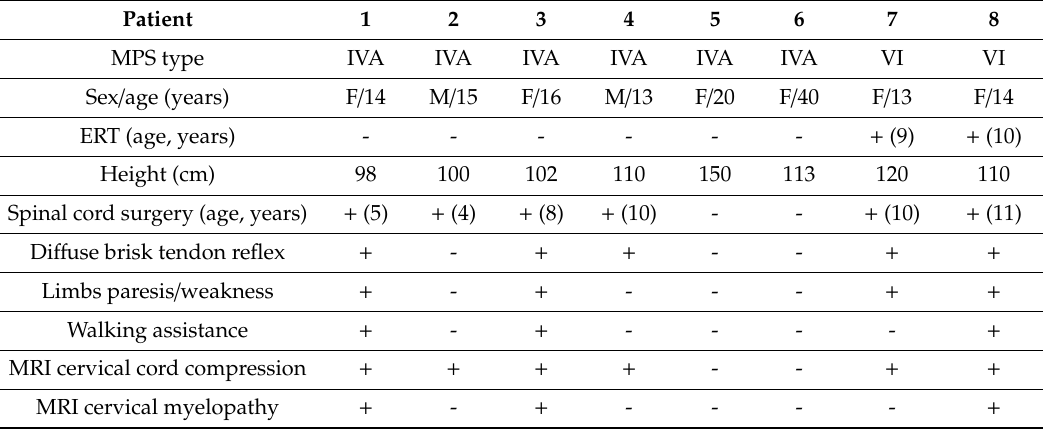
Table 1. Clinical and demographic characteristics of MPS patients at the time of the